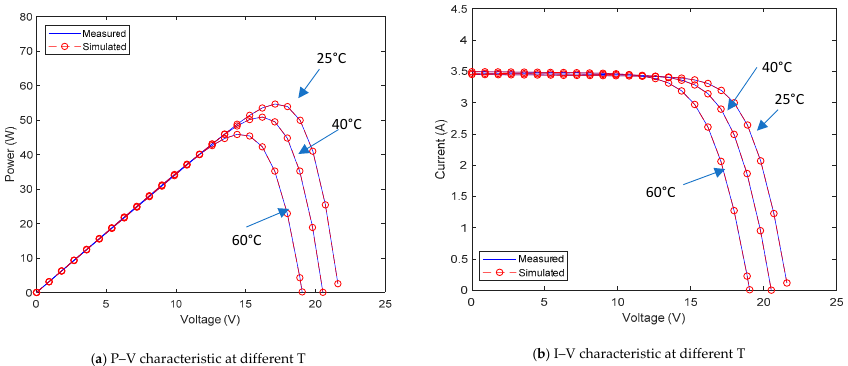
Figure 12. Depiction of the principal characteristics on SM55 module at varied temperatures.